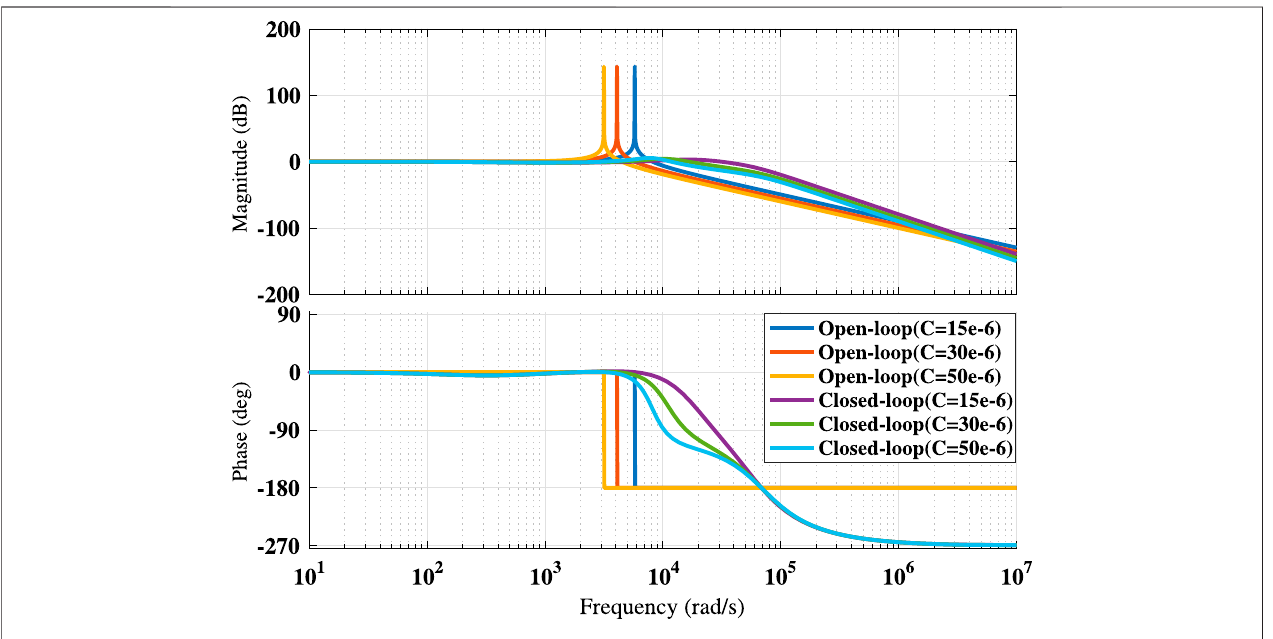
FIGURE 8 | Comparison of open and closed-loop Bode diagram for various capacitor